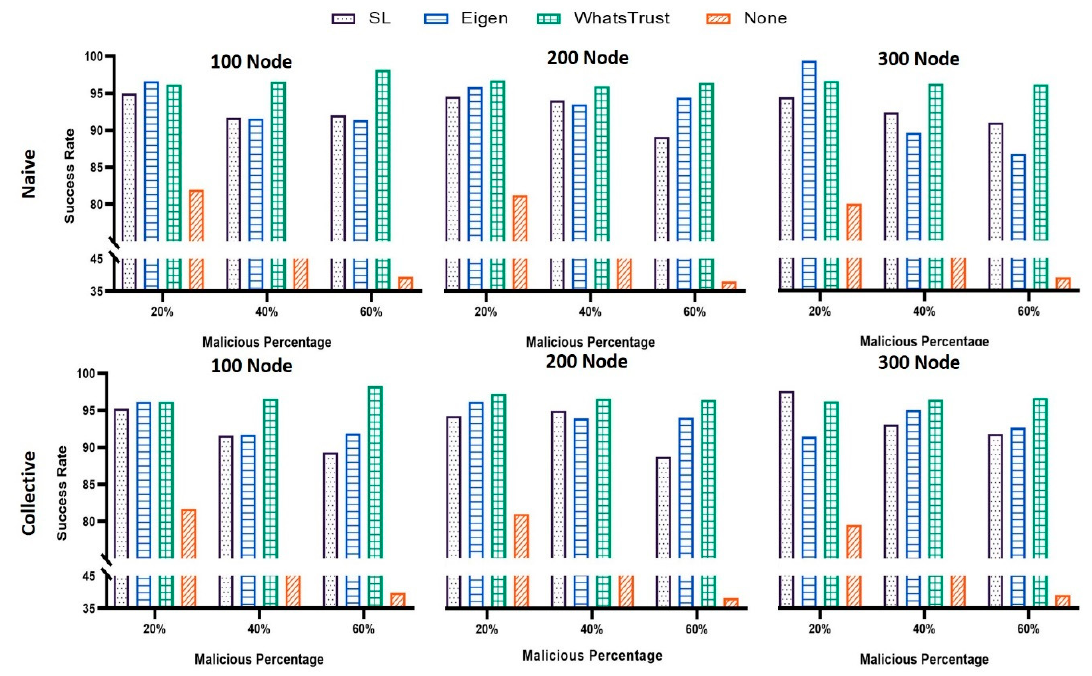
Figure 6. Success rate for 2000 transactions.